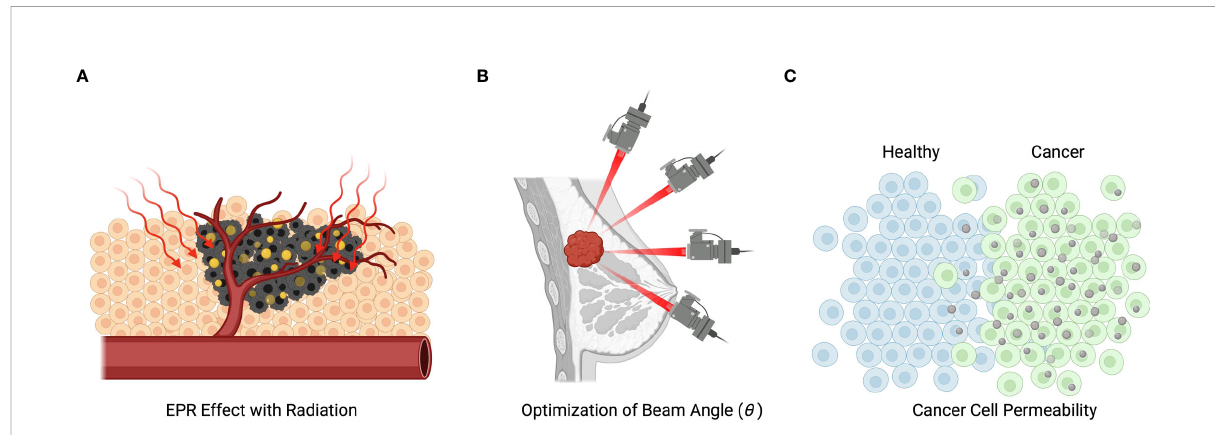
FIGURE 3 Mechanisms of radiation and nanotechnology-based treatment. (A) Illustration of nanoparticles entering the metastatic cells and being subsequently activated by radiation. (B) Illustration of the spatial selectivity of traditional radiotherapy, which is spatially selective, but can cause death of not metastatic cells. (C) Demonstration of how metastatic selectivity together with spatial selectivity can enhance treatment ef fi